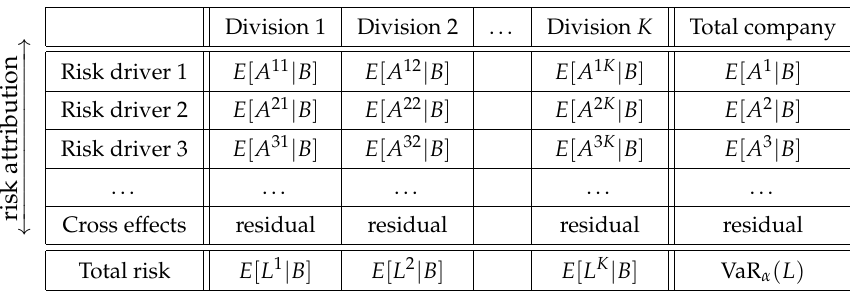
) ) , and B = { f (( R i i T